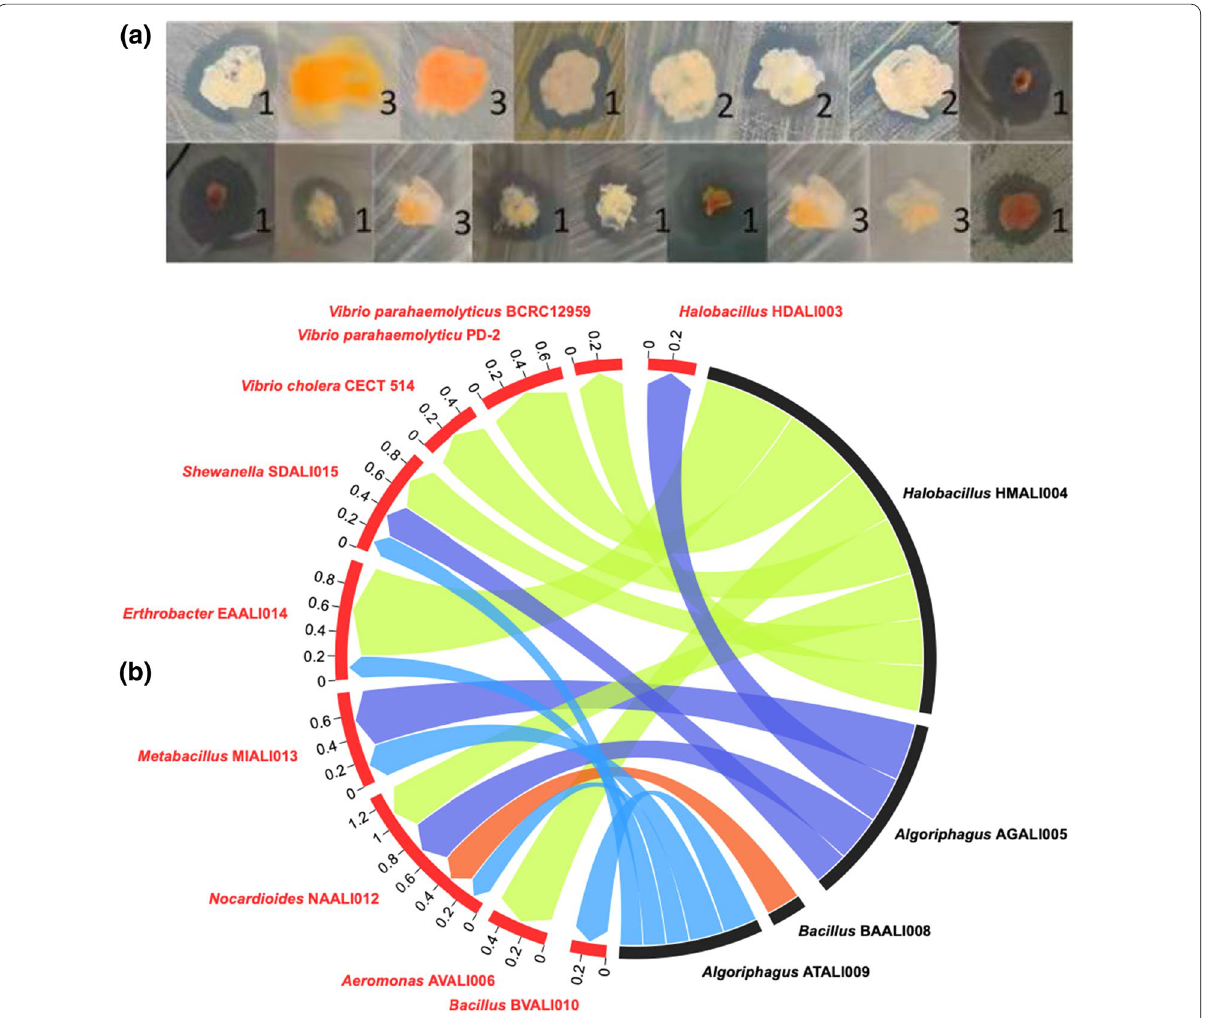
Fig. 4 Inhibitory activity ( a ) and Chord-diagram ( b ), Inhibitory zone in a is labeled with 1 for strong, 2 for weak, and 3 for no inhibition based on halo size. In Chord-diagram the targeted strains (inhabited) marked in red color, whereas strains with probiotic activity was highlighted in black color. The findings show that probiotics bacterial isolates such as H. marinus HMALI004, B. aequororis BAALI008, A. sanaruensis AGALI005 and A. taiwanensis ATALI009 inhabited the growth of N. aestuarii NAALI012, E. alti EAALI014, S. decolorationis SDALI015, B. vietnamensi BVALI010, H. dabanensis HDALI003, V. parahaemolyticus PD-2, V. cholerae CECT 514T, and non AHPND V. parahaemolyticus BCRC12959. The number at the end of nodes represents the inhibitory values in